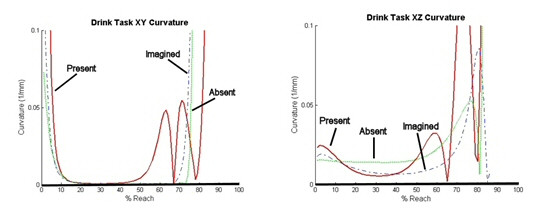
Curvature in the XY and XZ Planes. Left: Curvature in the XY plane plotted against % Reach. Average minimal curvature = .0007/mm. Right: Curvature in the XZ plane plotted against % Reach. Average minimal curvature = .0031/mm.